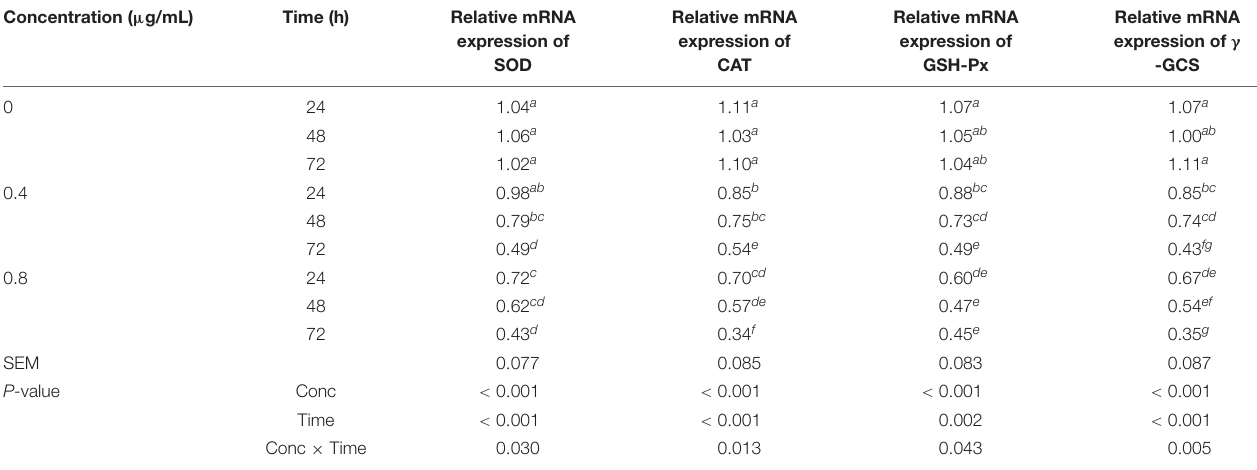
TABLE 9 | Effects of α -chaconine on the relative mRNA expression of antioxidant enzyme genes superoxide dismutase (SOD), catalase (CAT), glutathione peroxidase (GSH-Px), and γ -glutamylcysteine synthetase ( γ -GCS) in mouse intestinal epithelial cells. Concentration ( µ